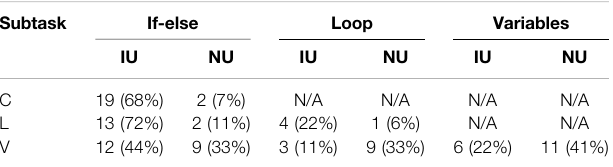
TABLE 1 | Classi fi cation of mistakes in the navigation task (improper use, IU; no use, NU) per programming statement per subtask [conditional (C), loop (L), and variables (V)].